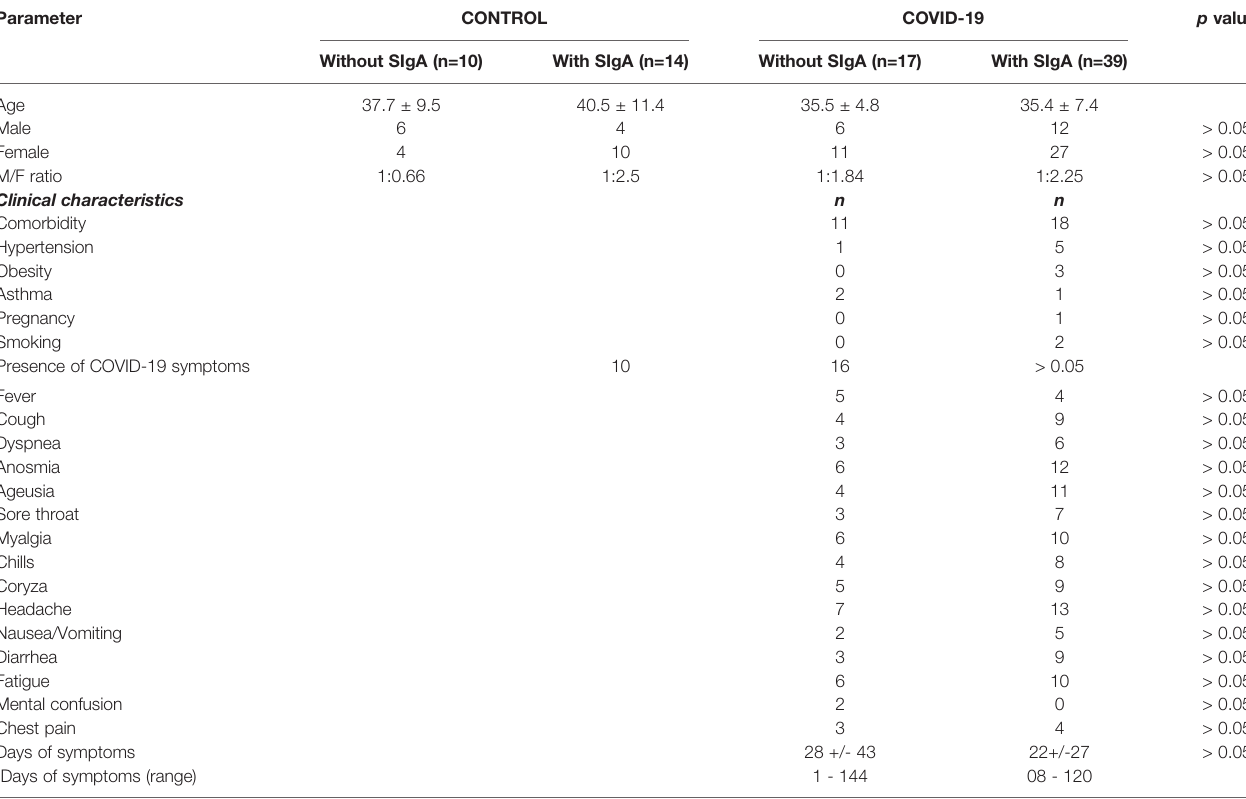
TABLE 1 | Demographic, clinical characteristics, and symptoms presented by the patients who composed the COVID-19 sub-groups without or with SIgA.